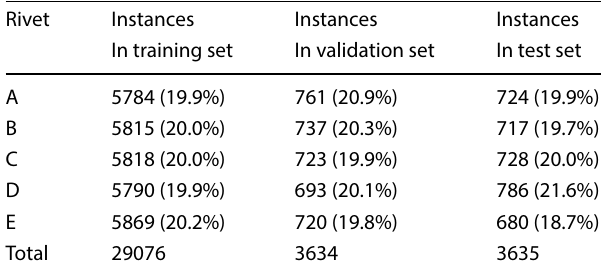
Table 3 Final data set (Mix4) and the amount of each rivet in the training, validation, and test set, respectively. The distribution was achieved with a random shuffle of the entire data set Rivet